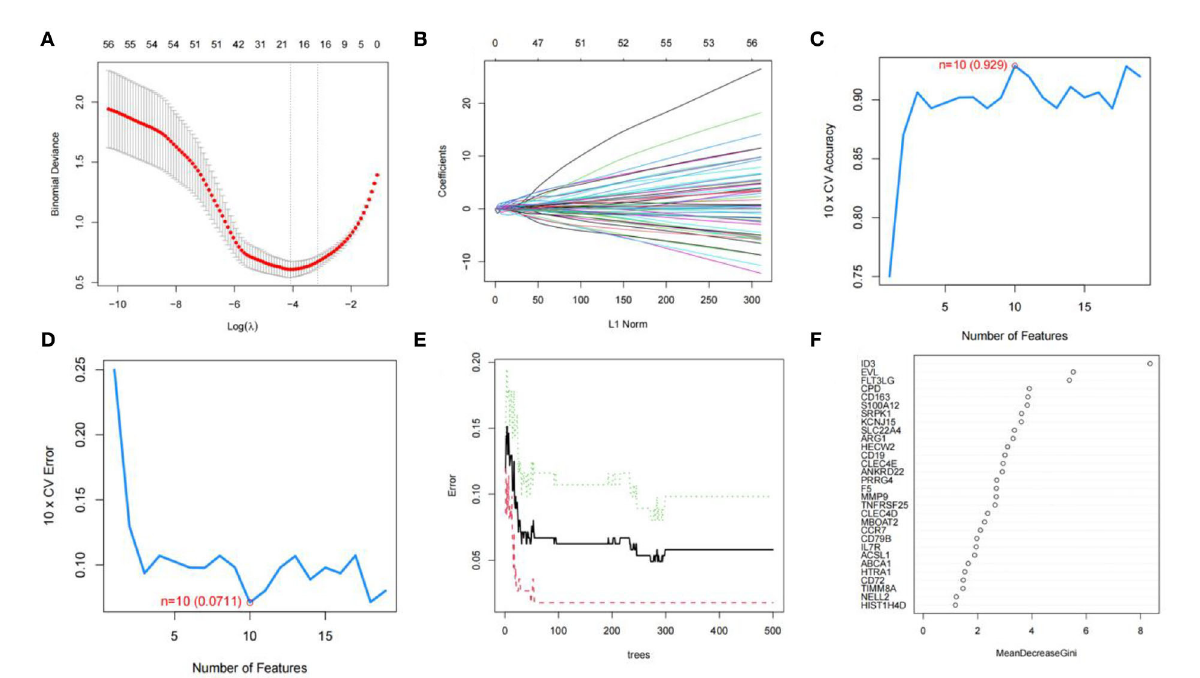
FIGURE4 Screening for feature genes. (A) Identification of the optimal penalization coefficient lambda ( λ ) in the LASSO model. (B) Cross-validation for tuning parameter selection in the LASSO model. (C,D) A plot of genes selection via SVM-RFE algorithm. (E) The influence of the number of decision trees on the error rate. The x- axis represents the number of decision trees, and the y -axis indicates the error rate. (F) Results of the Gini coefficient method in RF model. The x -axis indicates the genetic variable, and the y -axis represents the importance index.